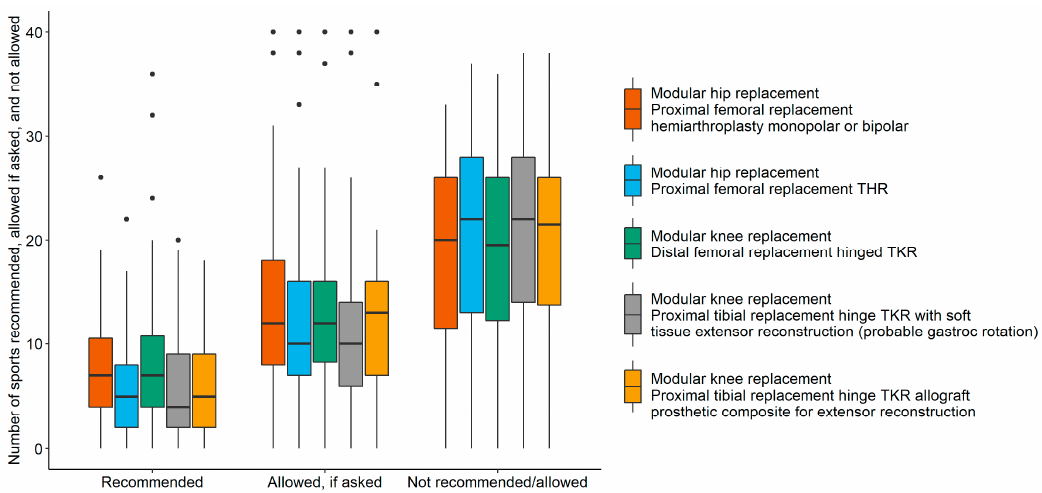
Figure 3. Number of recommended, allowed, and not allowed sports after surgery by procedure.